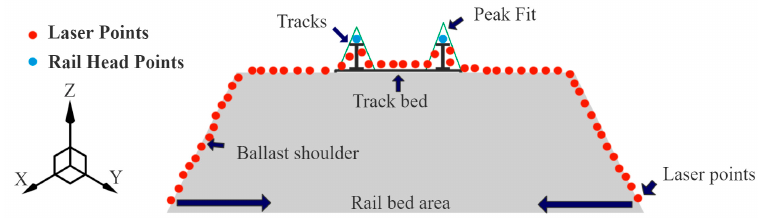
Figure 1. One profile of track bed represented by laser scan points.